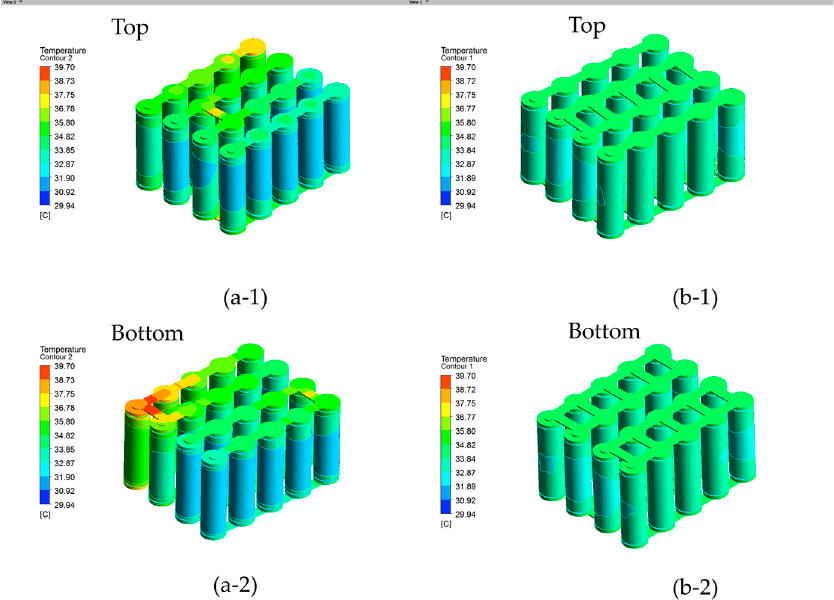
Figure 15. Battery module temperature contour viewed from top and bottom at a 3C discharge rate and 25 °C ambient temperature: ( a-1 ) and ( a-2 ) are model A and ( b-1 ) and ( b-2 ) are model B.